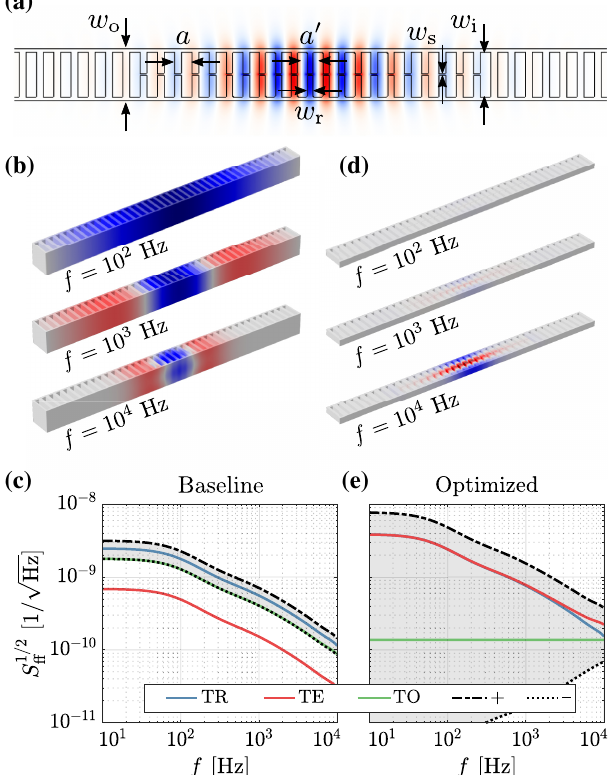
FIG. 6. Athermal polymer (PMMA) microcavity design by coherent thermo-optic noise cancellation. The Q -optimized base- ;w ;w line ladder-type nanobeam cavity (a) with f a;a 0 ;w o i s g¼ f 647 nm ; 0 . 914 a; 3 a; 0 . 85 w o ; 0 g and thickness t ¼ 3 a is formed by quadratically tapering the lattice constant a to a 0 over the inner w =a ¼ 0 . 4 . 12 periods with a constant “ rung ” duty cycle η r ¼ r This cavity is driven by anticorrelated volumetric and boundary heat sources corresponding to TR and TE noise, respectively, in FEM-based fluctuation-dissipation simulations. The composite ∝ ½ ∇ δ T ð ⃗ r; f Þ(cid:2) 2 is computed TO frequency noise spectrum S ff from the resulting harmonic temperature profiles δ T ð ⃗ r; f Þ (b). The TO noise level is bounded by the coherent ( − ) and incoherent ( þ ) sum of TR and TE contributions (shaded region). The optimized 697 nm ; 0 . 874 a; 3 a; 0 . 85 w ;w ;w ;t; η ; parameters f a;a 0 ;w o i s r g¼f o 10 nm ; 0 . 8 a; 0 . 6 g provide broadband TON cancellation (e) as visually depicted by reduced δ T ð ⃗ r; f Þ at low frequencies (d). The color scale in (d) is equal to (b) to facilitate